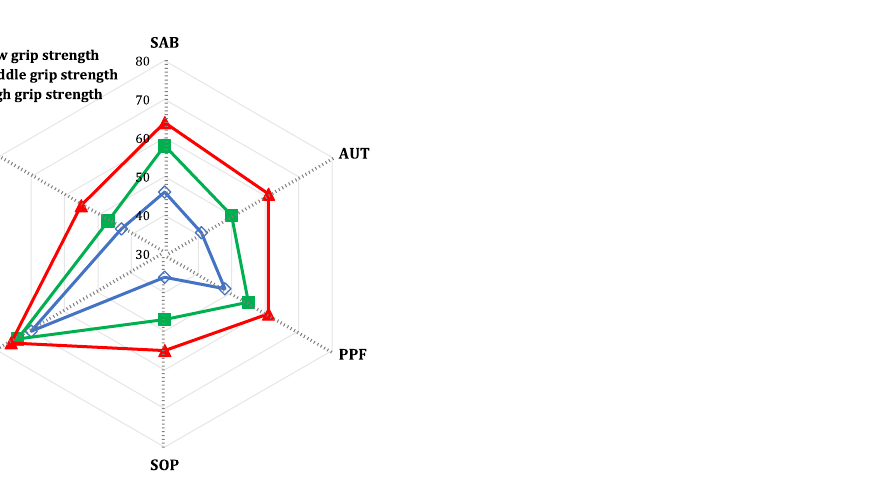
Figure 1. A radar plot on the WHOQOL-OLD scores for all six domains by the tertiles for grip strength. Note: SAB = sensory ability; AUT = autonomy; PPF = past, present, and future activities; SOP = social participation; DAD = perception of death and dying; INT = intimacy. Table 2 summarizes the results of linear regression models, estimating the association between grip strength and QOL, overall and by each domain, and with and without adjustment for the covariates. A significant association between grip strength and overall QOL was identified. Compared with older adults with low grip strength, those with middle grip strength ( β = 2.04, p = 0.027) and high grip strength ( β = 4.40, p < 0.001) had greater overall QOL after adjustment of potential confounders. Additionally, a significant, positive linear trend in the association between grip strength and overall QOL was observed even after risk adjustment ( p for trend < 0.001). The proportion of variance explained by the differences in grip strength on the overall QOL was 5.3% after the full adjustments. Table 2. Multiple linear regression analyses for the associations between handgrip strength and WHOQOL-OLD, overall and in each domain ( n = 400). Main Independent